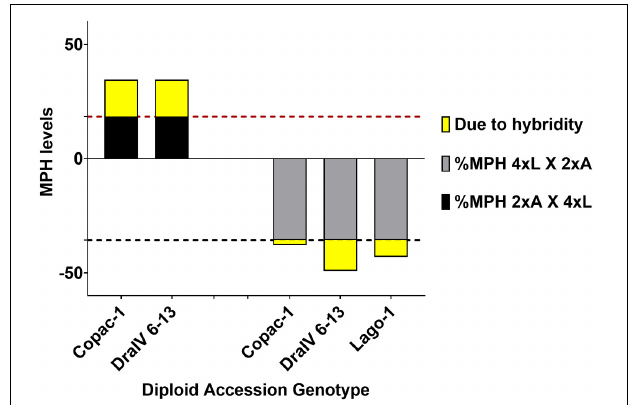
FIGURE 5 | Hybridity has a greater effect on F1 seed size heterosis at the triploid level (3x). Mid-Parent Heterosis (MPH) levels in F1 3x seeds from reciprocal inter-ploidy crosses are shown. 2xA X 4xL (2x Accession X 4x L er -0), 4xL X 2xA (4x L er -0 X 2x Accession). The proportion due to hybridity is highlighted in yellow and it was calculated by subtracting the %MPH of reciprocal L er -0 F1 isogenic inter-ploidy crosses (18.4% for 2x4 crosses, represented by a horizontal red dashed line, and –35.7% for 4x2 crosses, represented by a horizontal black dashed line) from the MPH levels of F1 hybrid